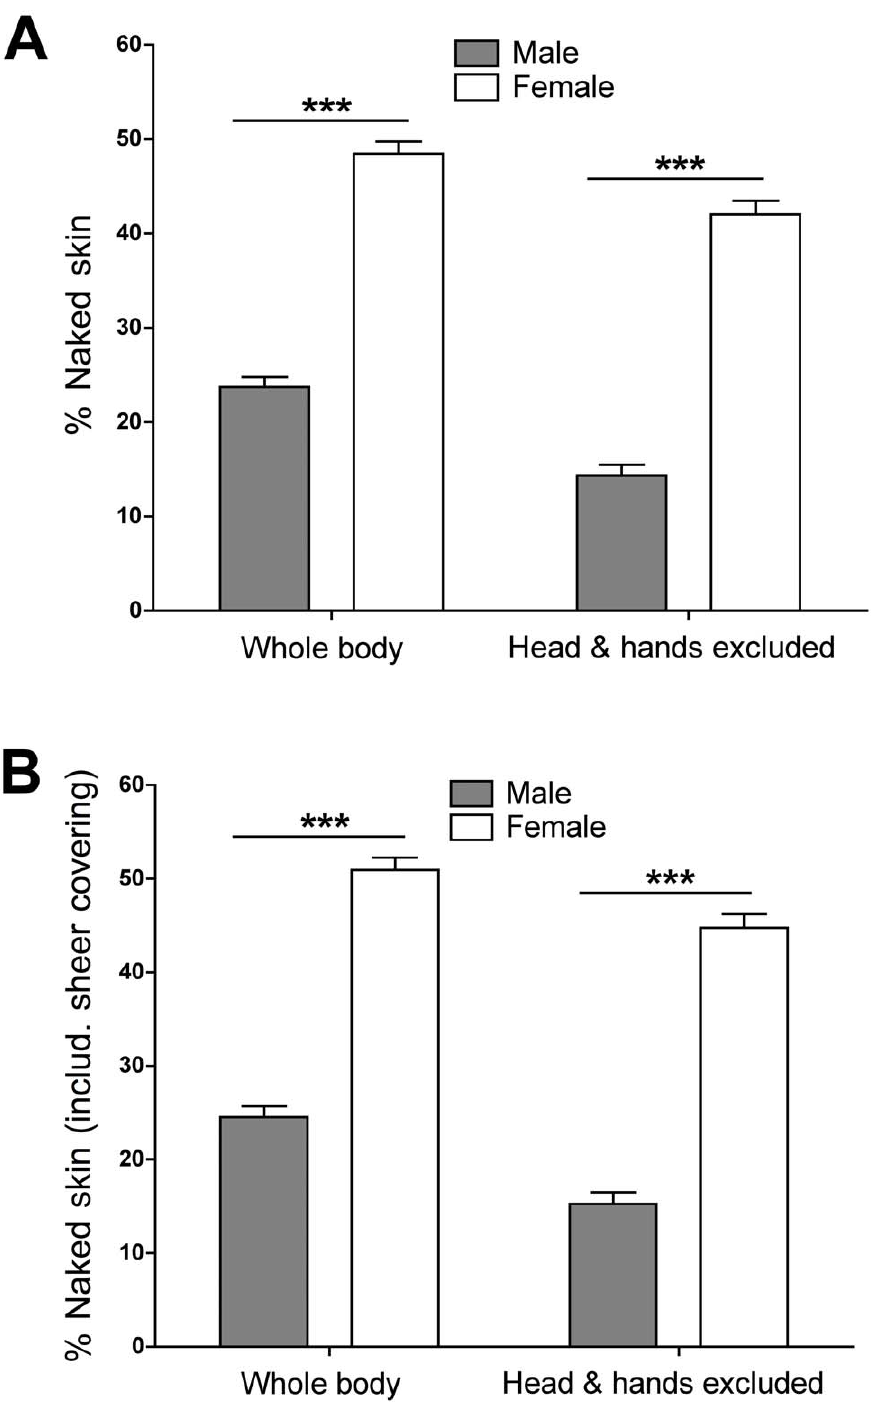
Figure 2. Degree of skin disclosure among virtual males and females. Shown is the percentage of exposed naked skin among male and female avatars in relation to the area of the entire body and of the body excluding the head and hands. Female avatars revealed twice as much naked skin as male avatars (A) and this difference was even more pronounced when sheer skin covering was considered (B). Results are presented as means 6 SEM. *** p , 0.001.